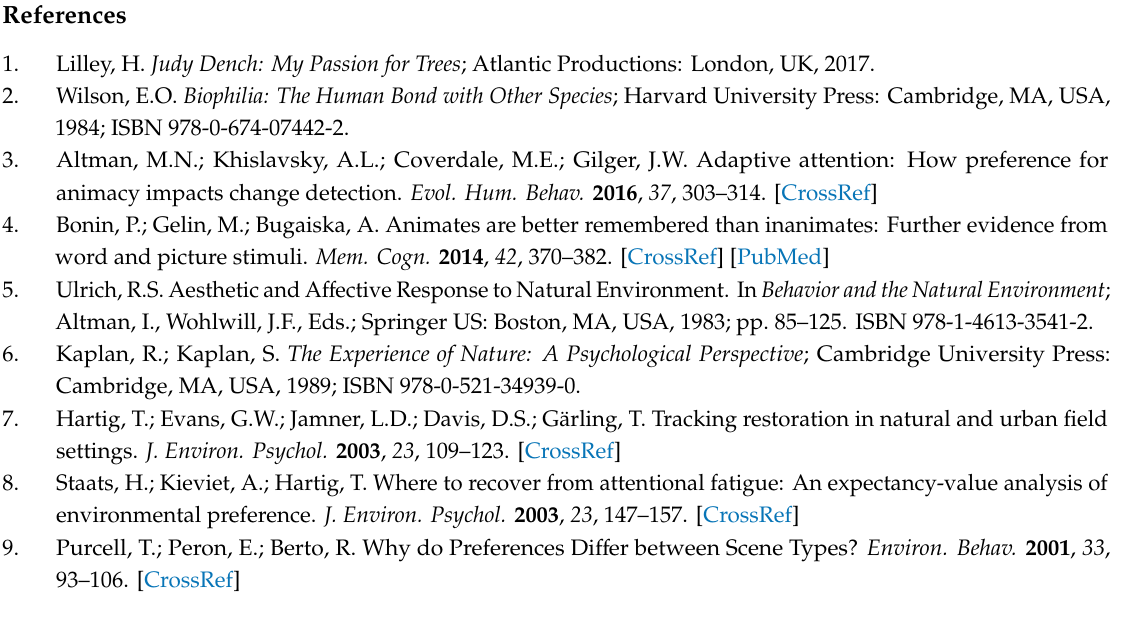
Table S1: The Links to the Audio Files from the BBC Sound E ff ects and Field Recordings Library. Author Contributions: Conceptualization, P.K. and K.B.; methodology, P.K. and K.B.; software, P.K.; data analysis, P.K. and K.B.; paper writing, P.K. and K.B. All authors have read and agreed to the published version of the